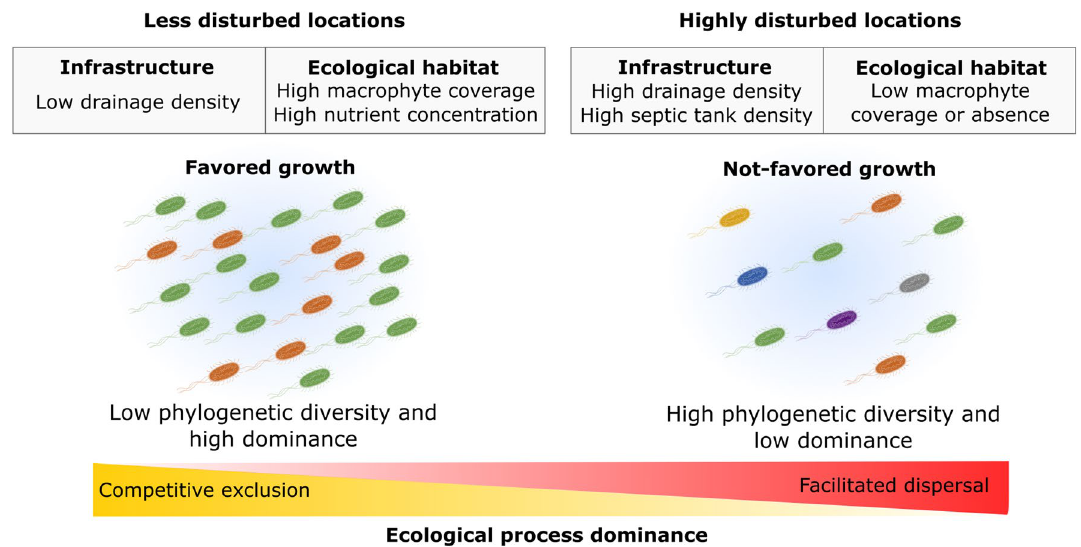
Figure 6. Hypothesized processes affecting the dynamics of E. coli population in an urban stream. Schematic diagram of contrasting scenarios along a gradient of environmental and urban conditions with different dominant ecological processes affecting the E. coli population. Graphic representation of E. coli from Togo picture gallery (Database Center for Life Science). https:// togotv. dbcls. jp/ en. Graphical edition in Inkscape V 0.92.4. Inkscape Project (2020). https:// inksc ape.